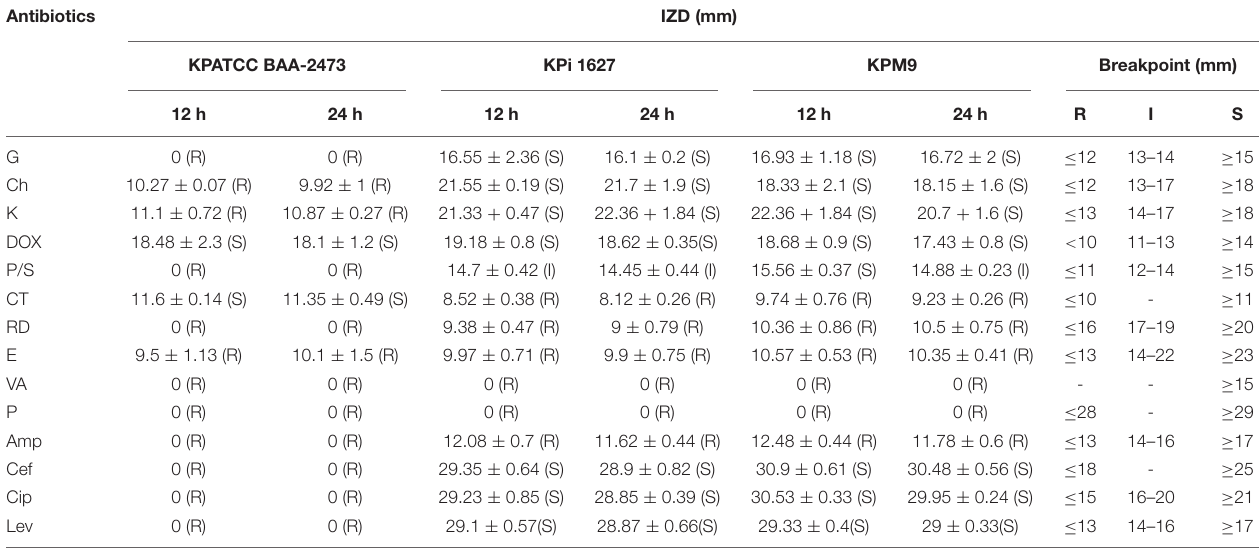
TABLE 1 | Antibiotic susceptibility of human Klebsiella pneumoniae strains.